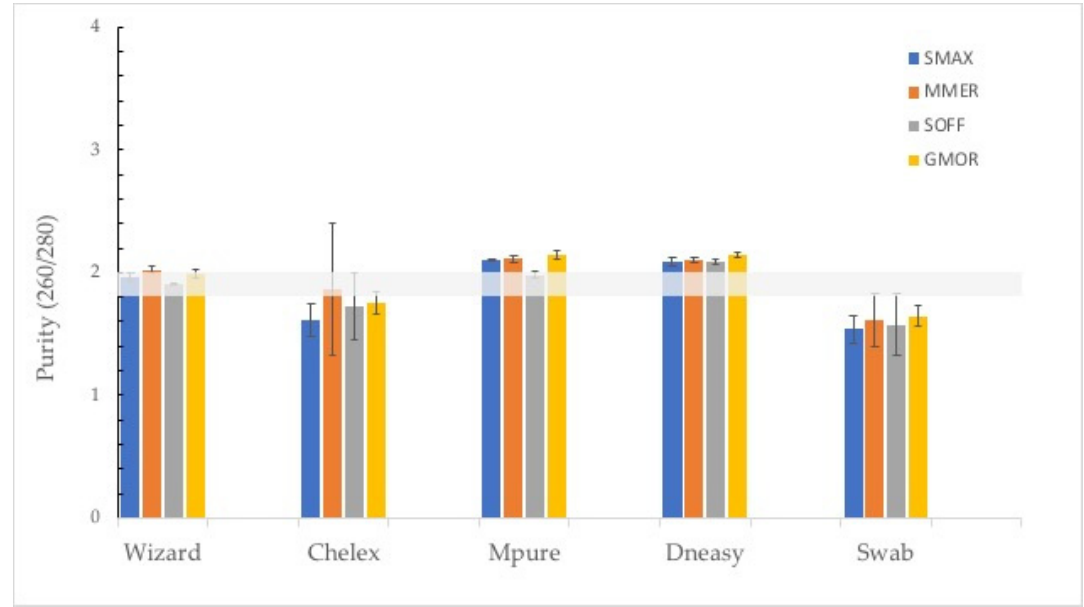
Figure 5. Purity (260/280) of the tested DNA extraction methods per species. Data are presented as mean ± SD of individuals per species . Scophthalmus maximus (SMAX), Merluccius merluccius (MMER), Sepia officinalis (SOFF) and Gadus morhua (GMOR).